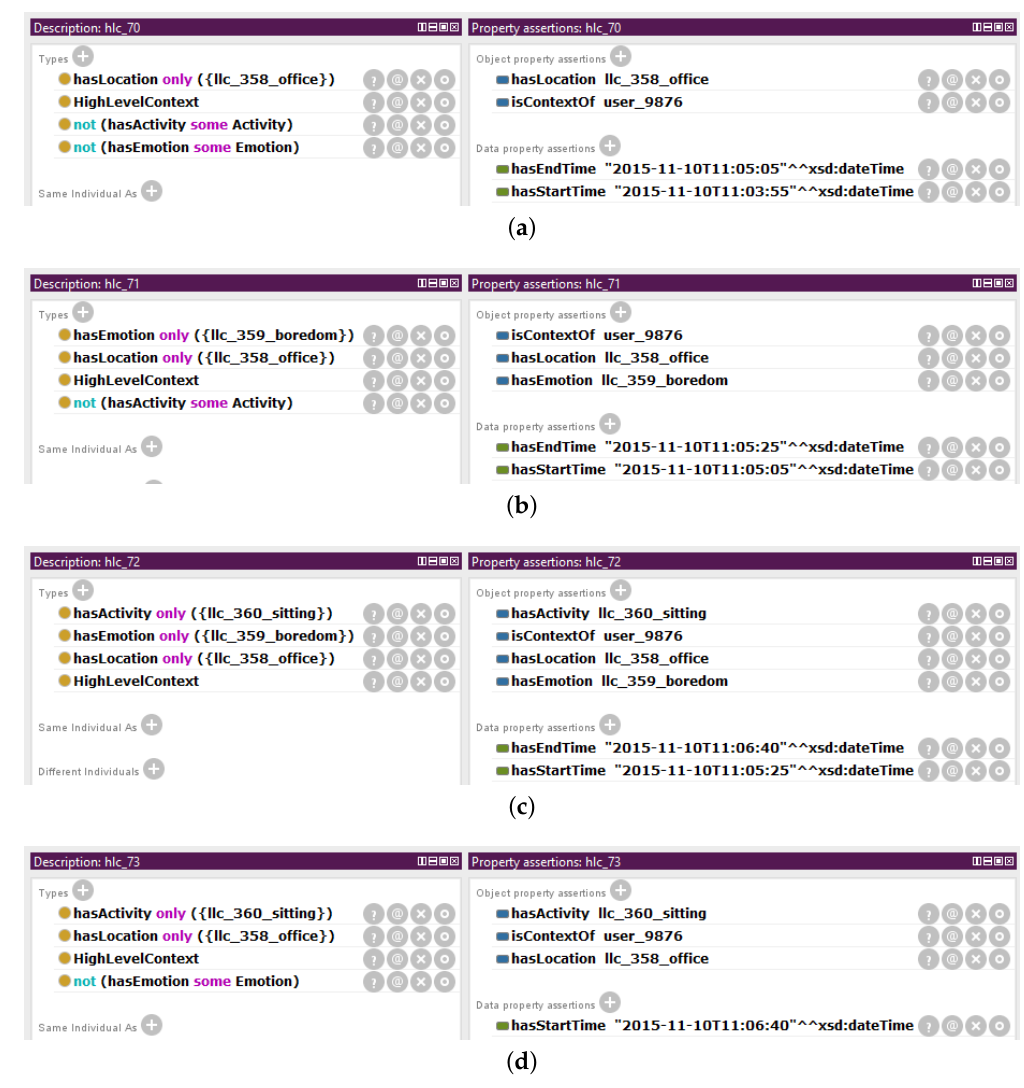
Figure 6. Representation of the instances of unclassified high-level context for the exemplary scenario by using the Mining Minds Context Ontology in Protégé. ( a ) hlc_70 ; ( b ) hlc_71 ; ( c ) hlc_72 ; and ( d ) hlc_73 are composed of some of the low-level contexts llc_358_office (member of the class Office ), llc_359_boredom (member of the class Boredom ) and llc_360_sitting (member of the class Sitting